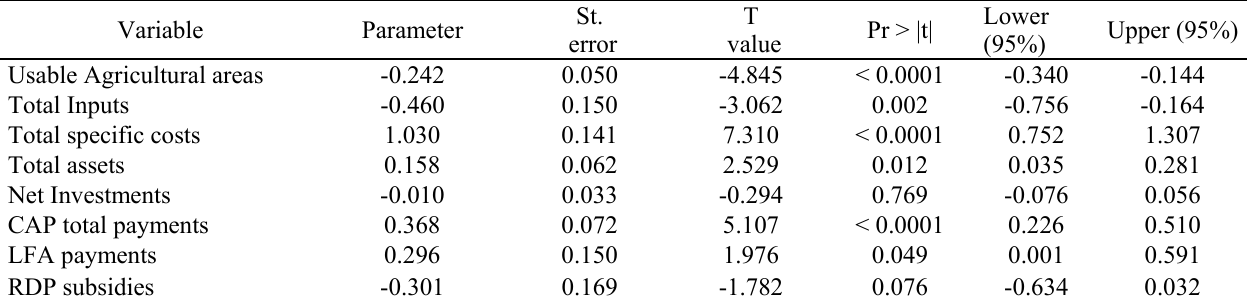
Main findings in the multiple regression model with the normalization of all variables. Dependent variable farm net income. (Source: author’s elaboration on data